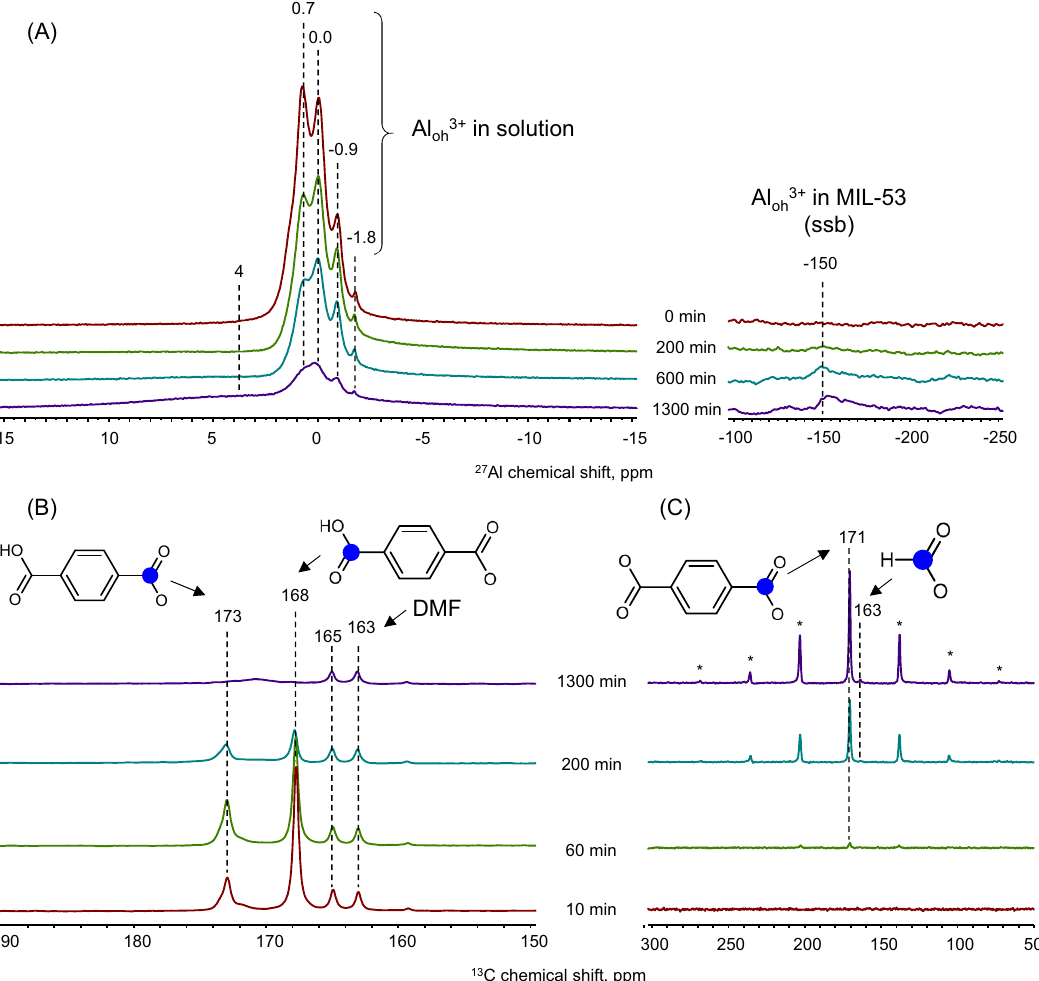
Fig. 2 Time-resolved MAS NMR data. Exeplary time-resolved ( A ) 27 Al, ( B ) 13 C direct excitation without proton decoupling, and ( C ) 1 H- 13 C CP-MAS with proton decoupling MAS NMR spectra. The reaction temperature was 343 K, MAS spinning rate varied between 3200 and 3500